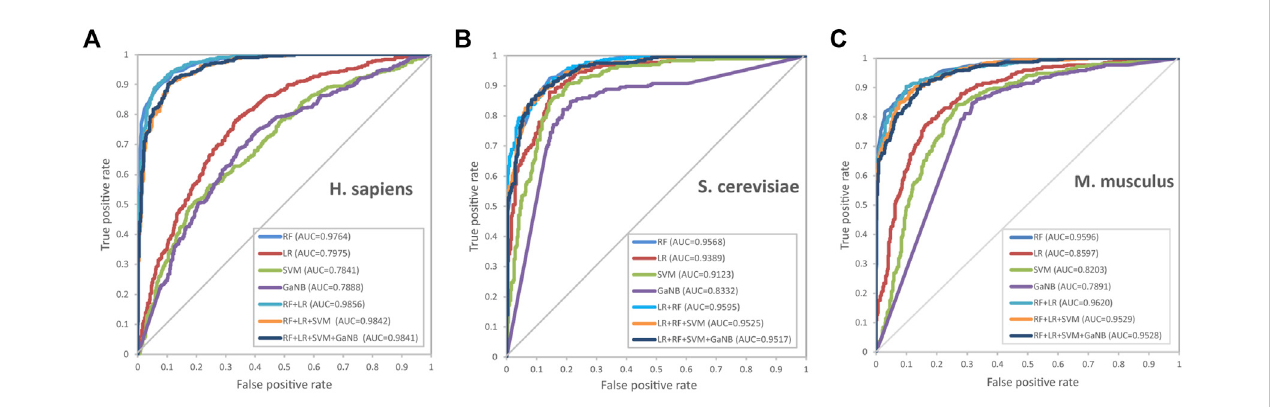
FIGURE 5 Receiver operating characteristic curves for the base classi fi ers and the stacked models of different base-classi fi er combinations during 5-fold cross- validation.Theverticalcoordinateisthetruepositiverate(sensitivity),whilethehorizontalcoordinateisthefalsepositiverate(1-speci fi city).[ (A) H.sapiens , (B) S. cerevisiae and (C) M. musculus